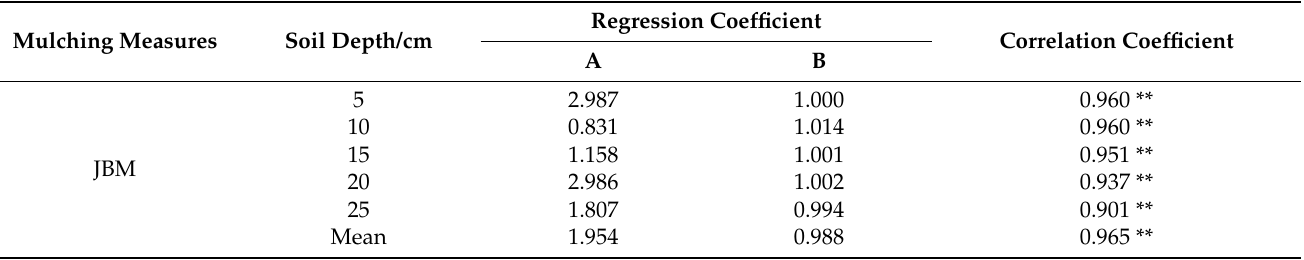
Table 3. Regression relationship between air and soil temperatures at different depths under different mulching